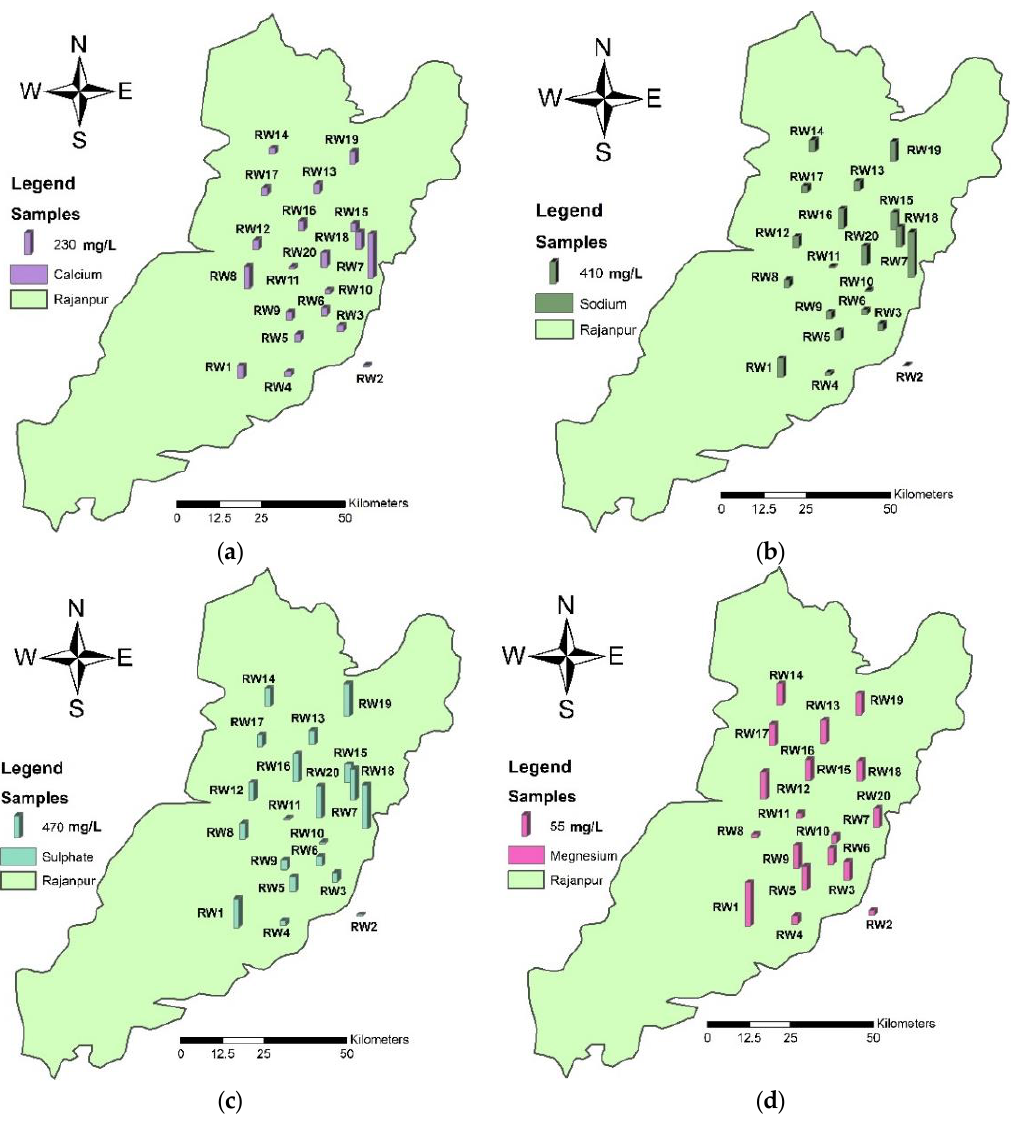
Figure 3. Spatial distribution maps of ( a ) calcium, ( b ) sodium, ( c ) sulfate, and ( d ) magnesium showing the concentration of elements at the location sites in the study area.